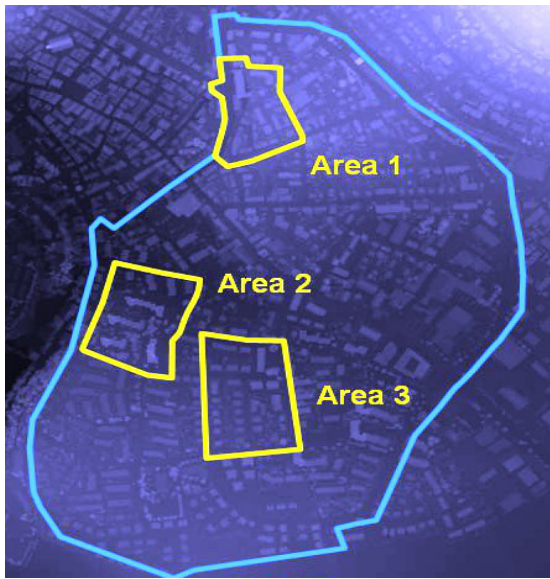
Figure 2. The three test areas shown on DSM The images are pan-sharpened colour infrared images with a